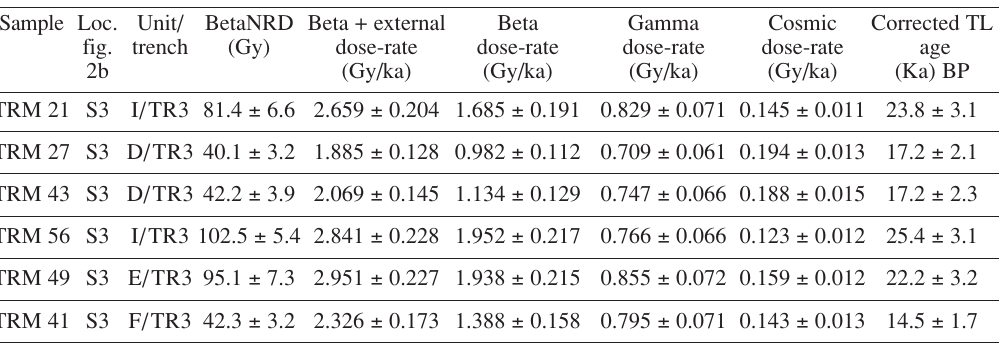
Table III. Absolute corrected ages (in years before the present) obtained with thermoluminiscense method for 6 samples collected at site S3 (see fig. 2b). The values of beta, gamma and cosmic dose-rate assessments are shown.